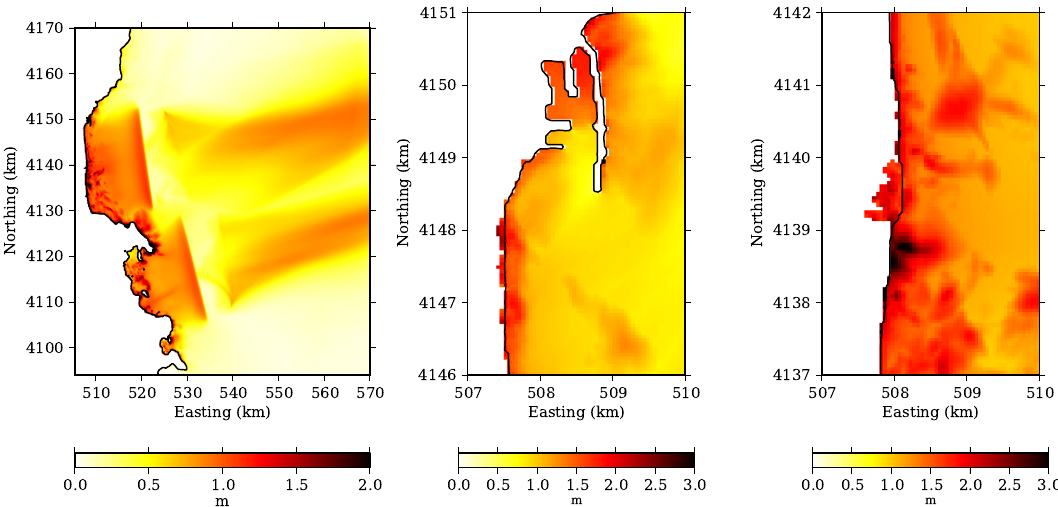
Fig. 23. Maximum elevations calculated after 2h of tsunami propagation in the whole domain (on the left), in the harbour of Catania and La Plaia beach (in the middle) and in the natural park called “Oasi del Simeto” (on the right), which is found in the southern part of the Gulf of